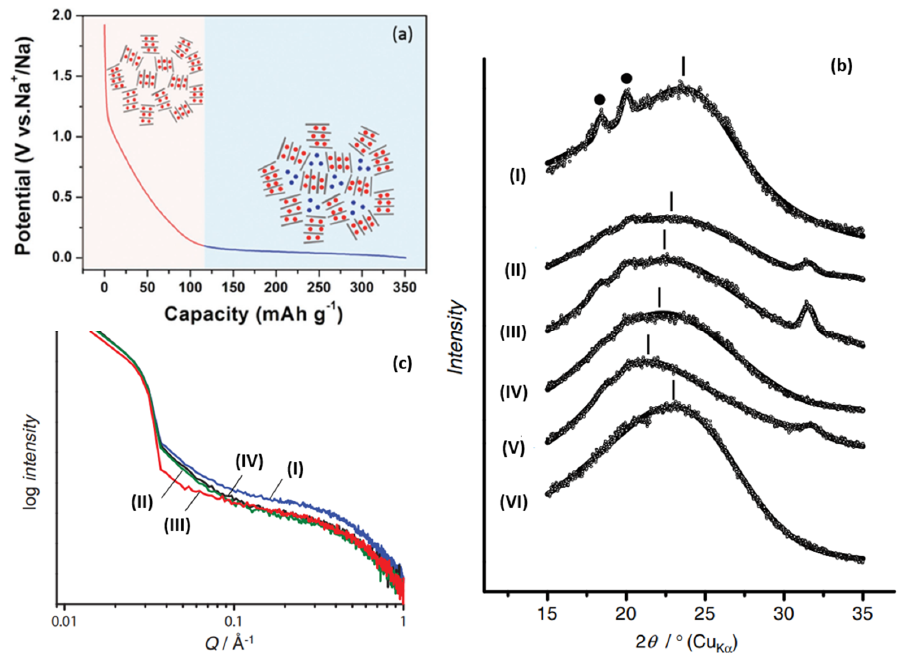
Figure 5. ( a ) Schematic illustration of the “intercalation-adsorption” mechanism for Sodium-ion storage in HC [63]. ( b ) Ex situ XRD patterns for HC electrodes: (I) pristine electrode, reduced in galvanostatic method to (II) 0.40 V, (III) 0.20 V, (IV) 0.10 V, (V) 0.00 V, and (VI) oxidized to 2.00 V after reduction to 0.00 V in 1 mol dm −1 NaClO 4 PC. (• PVDF binder) [61]. ( c ) Ex situ SAXs patterns for HC electrodes: (I) pristine, reduced in galvanostatic method to (II) 0.20 V, (III) 0.00 V, (IV) reoxidized to 2.00 V in 1 mol dm −1 NaClO 4 PC [61].